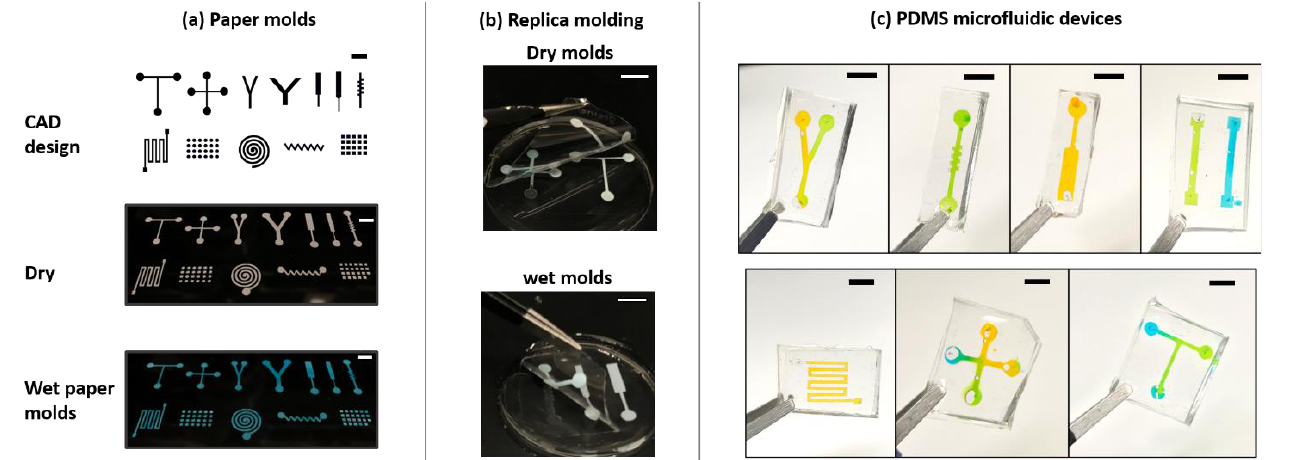
Figure 3. ( a ) Images showing CAD drawings and the corresponding dry and wet paper molds manufactured using the fabrication workflow. ( b ) Images showing that when the mold is dry or the amount of water added is not adequate enough, the molding process fails and the paper is stuck on the cured polymer, whereas adding the right amount of water results in a successful replica molding and the mold can be peeled off from the cured polymer layer. ( c ) Images showing the PDMS chips with various standard geometries fabricated from the wet molds. The scale bar for each image is 5 mm.